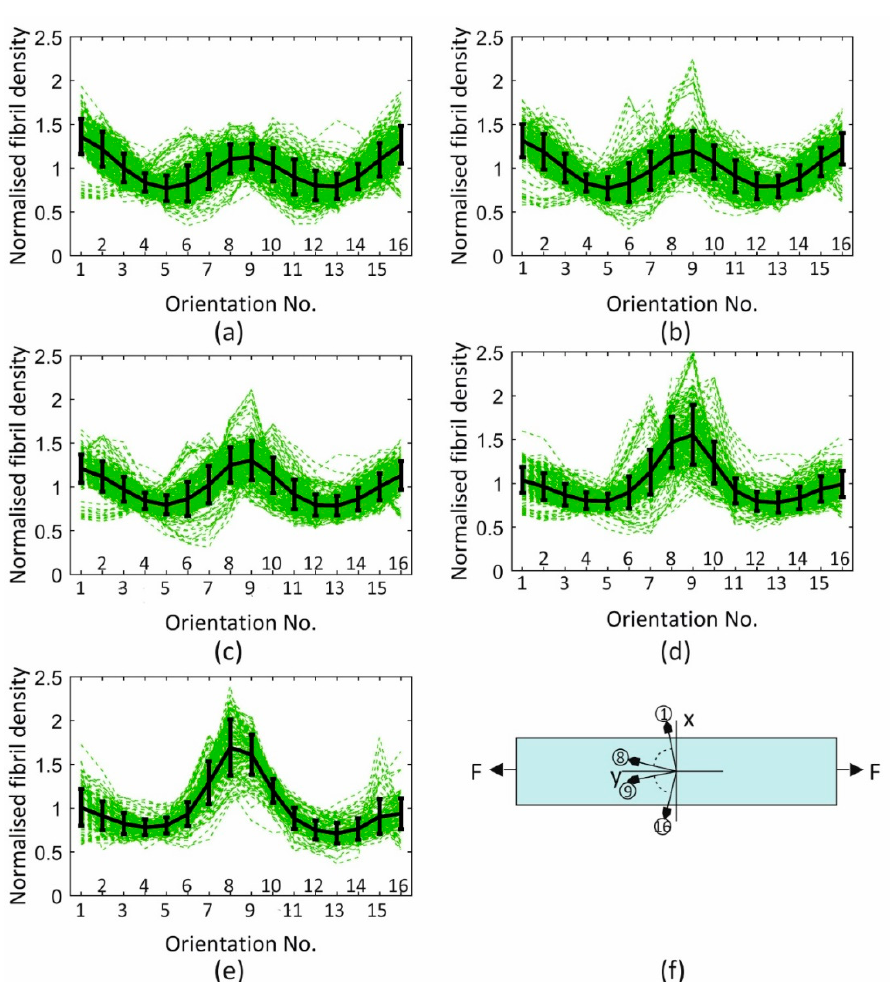
Figure 6. Mean and standard deviation of fibril density at all data points across specimen width recorded at s strain of ( a ) 0%, ( b ) 1.4%, ( c ) 2.8%, ( d ) 5%, and ( e ) 8%. The 16 discretised orientations considered in the figures are shown in ( f ). The orientations correspond to angle θ i = pi i = 1,2, ··· ,16 based on the local coordinate system, and this definition was adopted in the numerical modelling. Error bars represent the standard deviation of fibril density values.